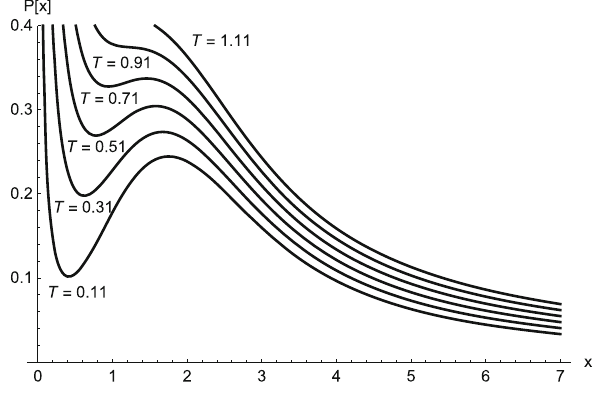
Fig. 3 Pressure from (53). Here v = 4 Gr + , x = r + / a , a 2 = 0 . 8, Gq 2 = 2 . 88 and G = r 0 =